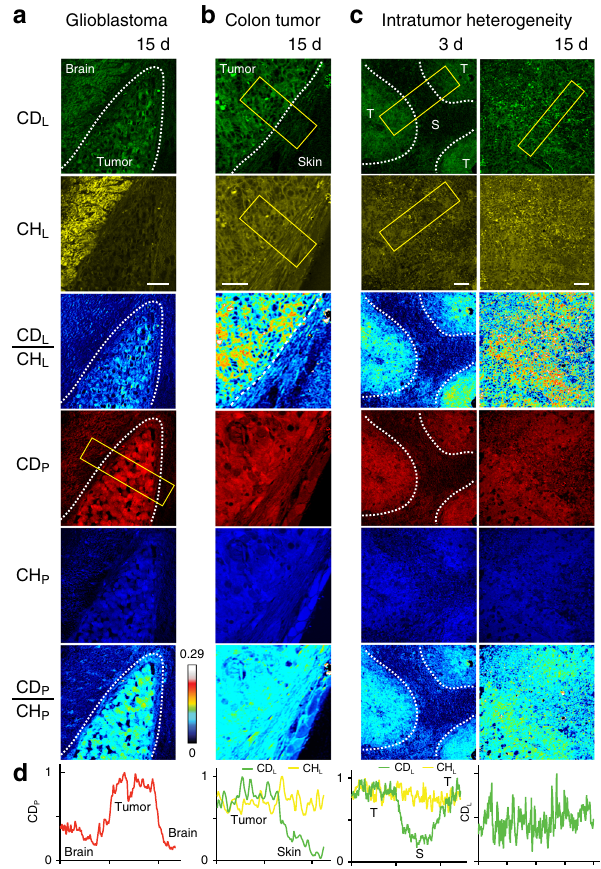
Fig. 9 DO-SRS microscopy identi fi es tumor boundaries and metabolic heterogeneity. a Intracranial xenograft glioblastoma in mouse brain was excised, sectioned, and imaged after the tumor-bearing mice drank 25% D 2 O for 15 days. Color scheme is similar to that in Fig. 2. Dashed curves highlight the tumor – brain boundary visualized by CD P signal. Intensity pro fi le quanti fi es the CD P signal within the yellow rectangle with x axis showing the position along the length of the box and y axis showing the average intensity across the width of the box. b Methods similar to a were used to visualize the tumor – skin boundary of subcutaneously xenografted colon tumor from the CD L channel. c The interior of the colon tumor xenografts was imaged after the tumor-bearing mice drank 25% D 2 O for 3 or 15 days. Dashed lines indicate the boundary between the tumor cells (labeled as T) and the recruited stromal cells (labeled as S), which were identi fi ed by the CD L signals at 3 days. Tumor and stromal cells were also identi fi ed by their different morphologies. Scale bar = 20 μ m. d Intensity pro fi le quanti fi es the CD P or CD L signal within the yellow rectangular with x axis showing the position along the length of the box and y axis showing the average intensity across the width of the